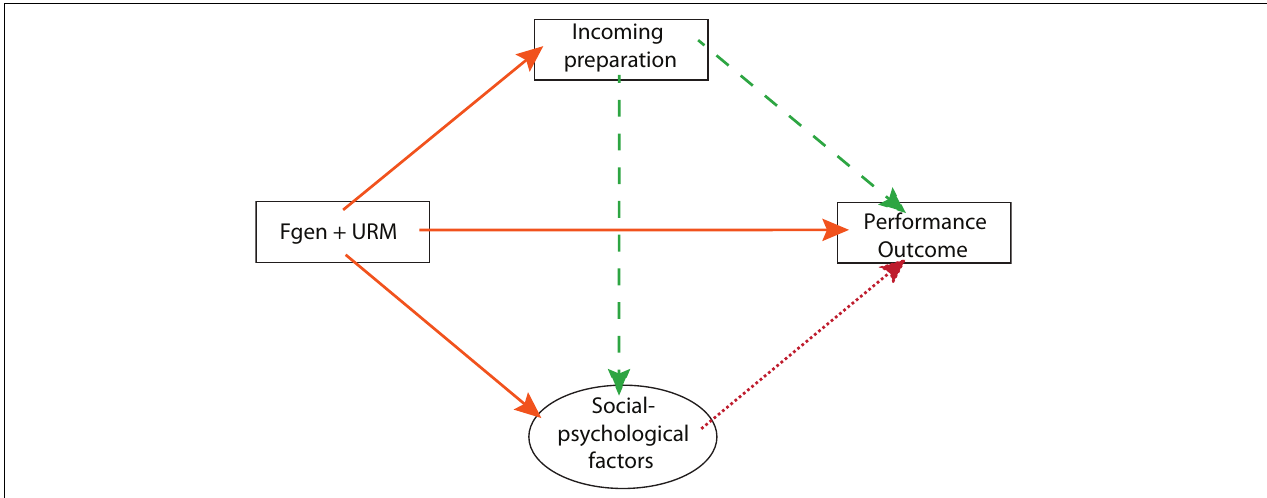
FIGURE 1 | A hypothesized partial. mediation model. This model depicts the structural relationship predicting student performance in introductory STEM courses. The three orange solid arrows from student demographic status (“URM + Fgen”) indicate that these traits predict incoming preparation, student social psychological factors, and performance (either exam or total grade). The two green medium-dashed arrows from incoming preparation reflect how preparation might predict student course performance, and social psychological factors. The red small-dashed arrow from social psychological factors shows how one or more factors we surveyed may influence student performance. In this partial mediation model, student demographic status affects performance both directly as well as indirectly through incoming preparation and/or social psychological factors. Note that in this model we controlled for student gender due to its demonstrable impact on performance, but do not depict that relationship here because it is not the focus of the current